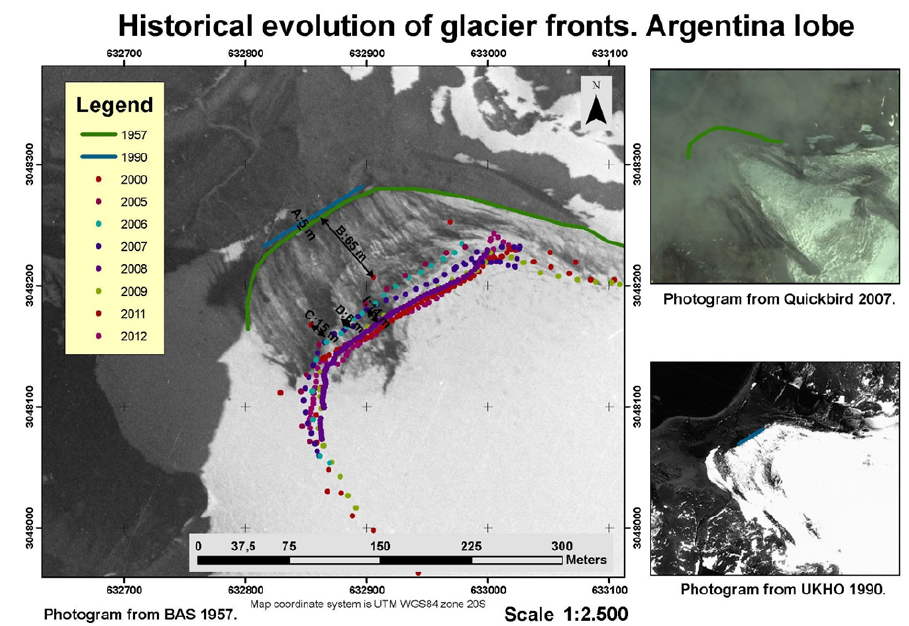
Figure 12. Terminus position changes of the front of Argentina side lobe of Hurd Glacier. The oldest front position available corresponds to 1957 (in purple) and the latest for the year 2012 (in cyan). The base map corresponds to the BAS aerial photograph of 1957. The outline marked on the “diffuse” 2007 Quickbird image corresponds to ground-based GNSS measurements. The scale bar shown in the figure does not match with the map scale